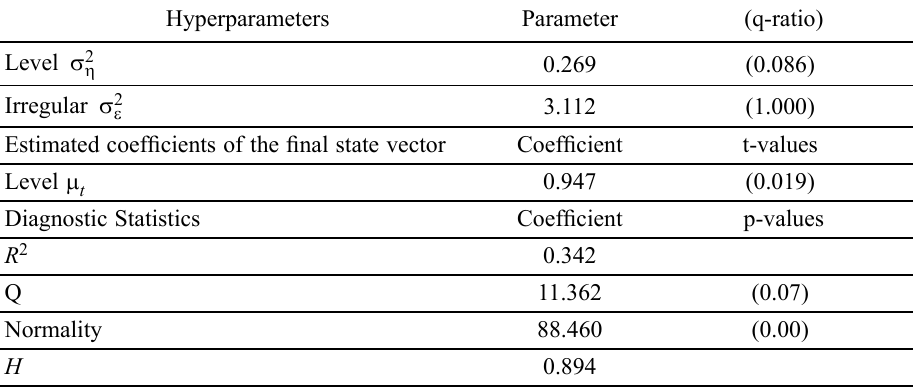
Table 5. Univariate unobserved components model of inflation: 1982(2)–2009(12)